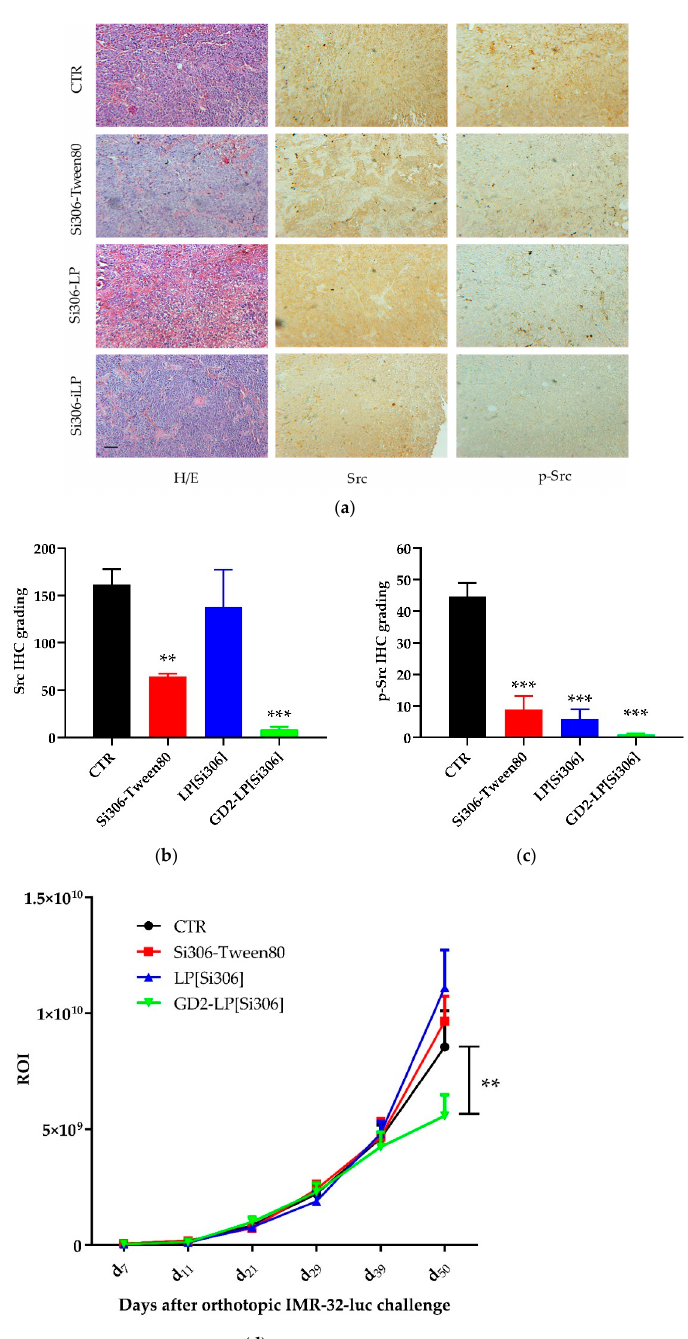
Figure 7. Si306 antitumor effect against an orthotopic animal model of neuroblastoma. Mice were injected in the adrenal gland with IMR-32-luc cells and treated with 5 mg/kg Si306, either free (Si306- Tween80) or encapsulated into untargeted and GD2-targeted liposomes (LP[Si306] and GD2- LP[Si306], respectively), as described in the Materials and Methods section. ( a ) Representative im- ages of histology (H/E) analysis and IHC staining (brown) for Src and p-Src proteins from tumor tissues of untreated (CTR) or treated mice (more brown staining, more Src and p-Src proteins ex- pression). Bar: 200 μ m. ( b , c ) Digital analyses of IHC grading of tumor tissues from the different experimental conditions. Histogram results from analysis of acquired images after Src ( b ) and p-Src ( c ) staining. Columns: mean ± SD. ** p ˂ 0.01 and *** p ˂ 0.001: vs. CTR. ( d ) Tumor growth delay followed by BLI imaging. Photon counts in the tumor Region of Interest (ROI) are reported. ** p ˂ 0.01: GD2-LP[Si306] vs. CTR, Si306-Tween80 and LP[Si306].